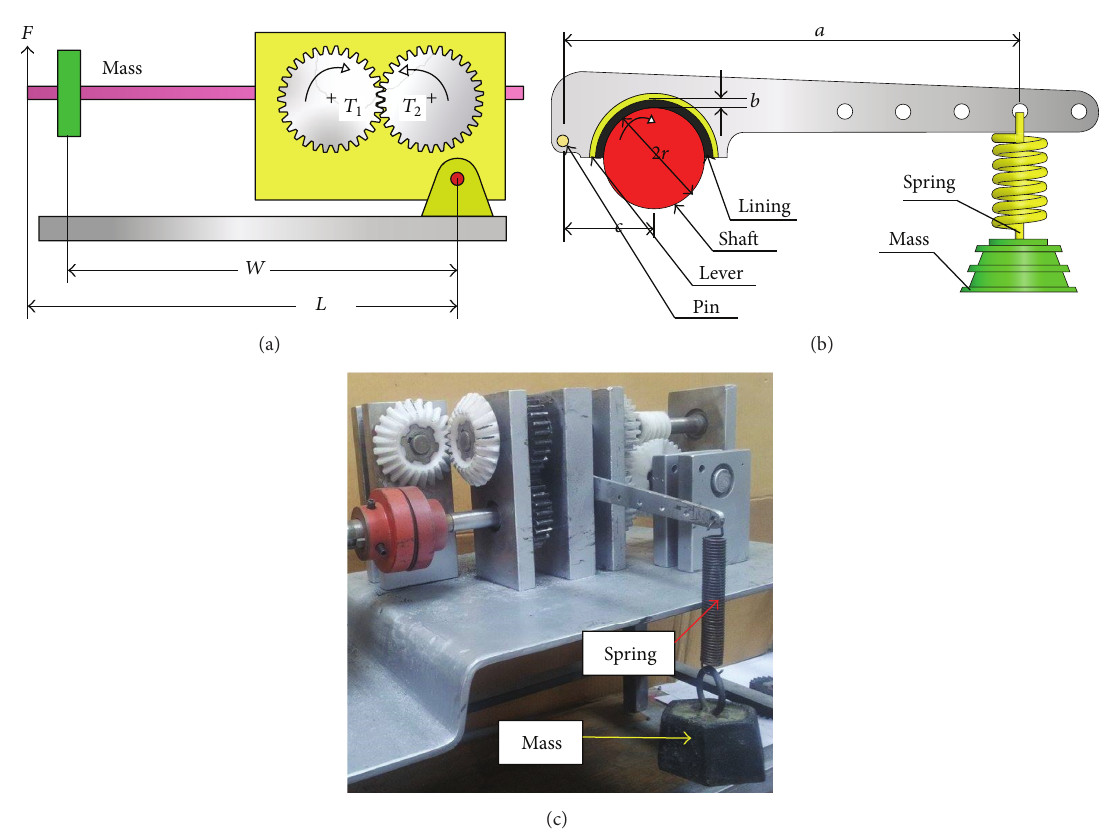
Figure 6: (a) Load principle of the Mk I test rig 1993, (b) TS universal test rig loading mechanism, and (c) a photograph view of load